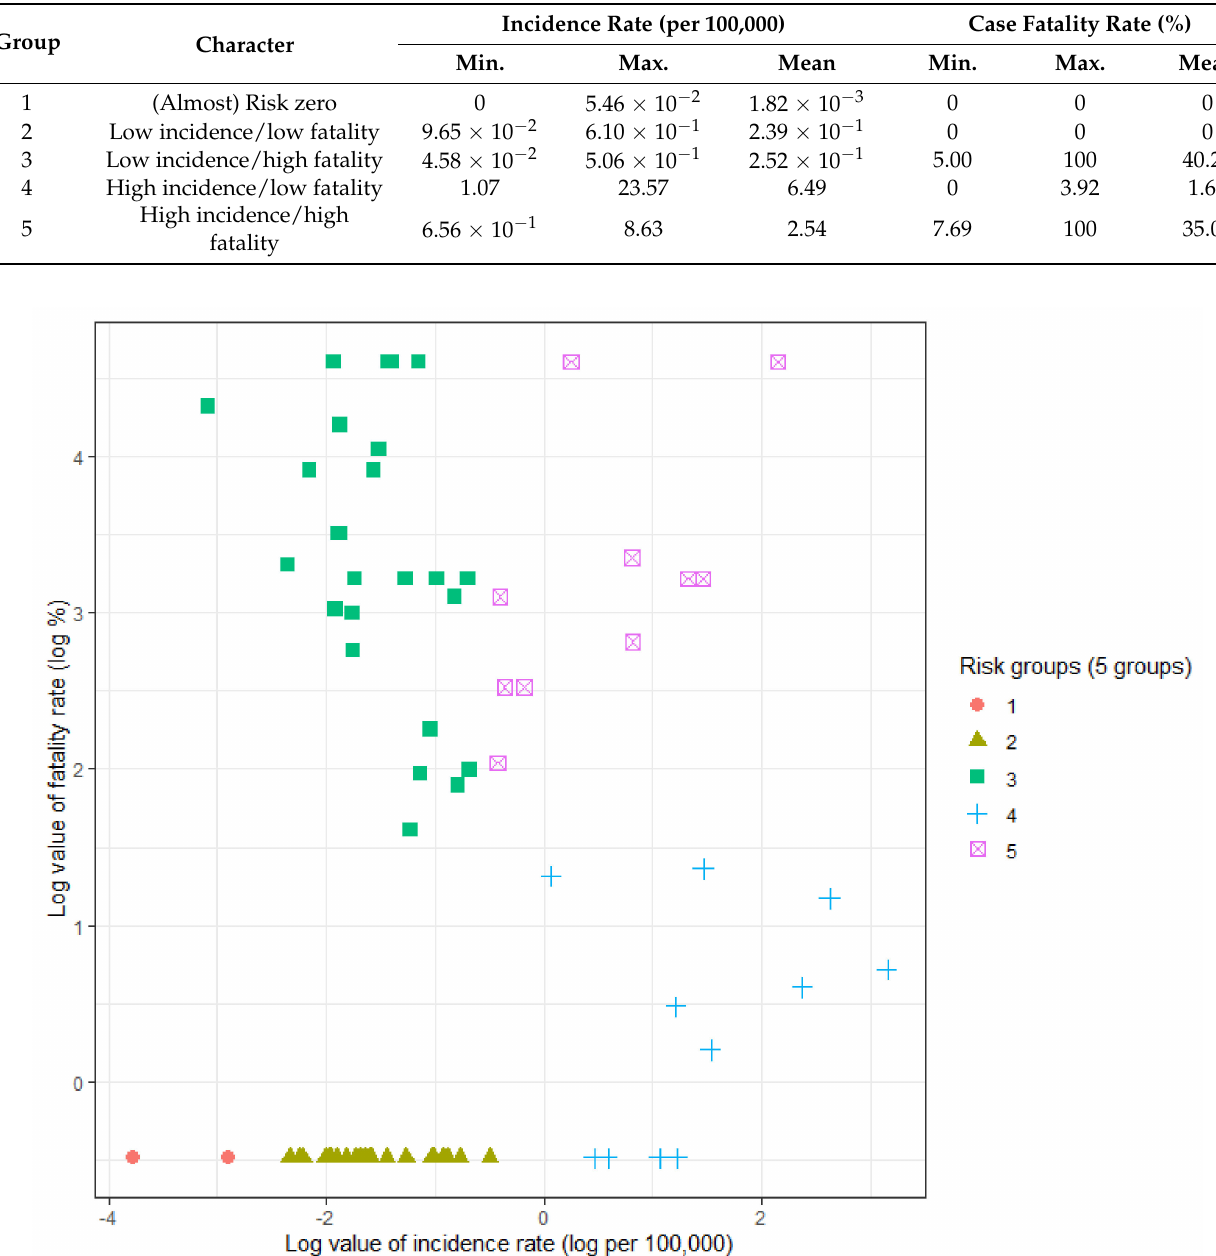
Table 5. Characteristics of risk groups by incidence and fatality rate of infectious diseases in Industrial Accident Statistics.